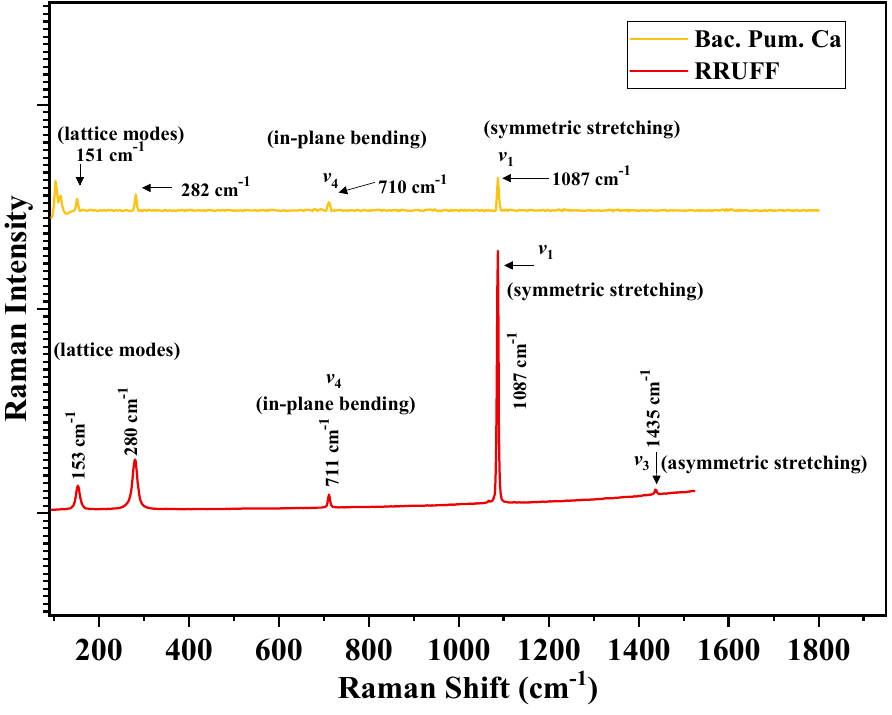
Figure 15. RAMAN spectra of healing precipitate from biodeposition treatment.